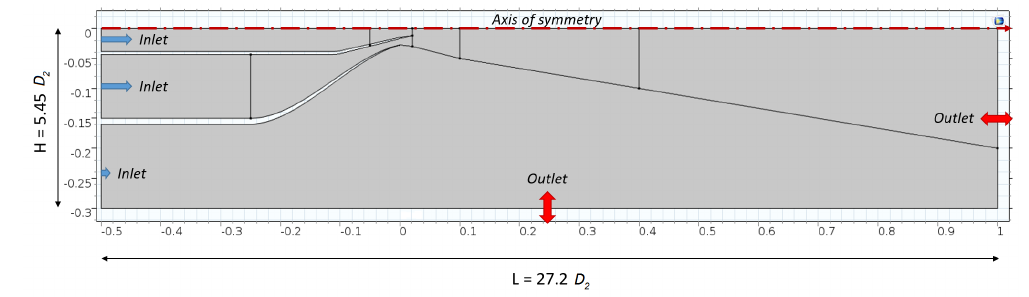
Figure 10. Example of the computational domain. Dimensions in m.